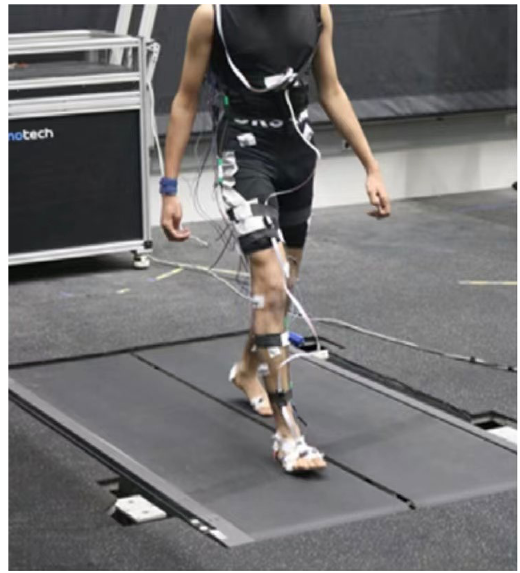
Figure 4. Experimental setup [14] of AB dataset.